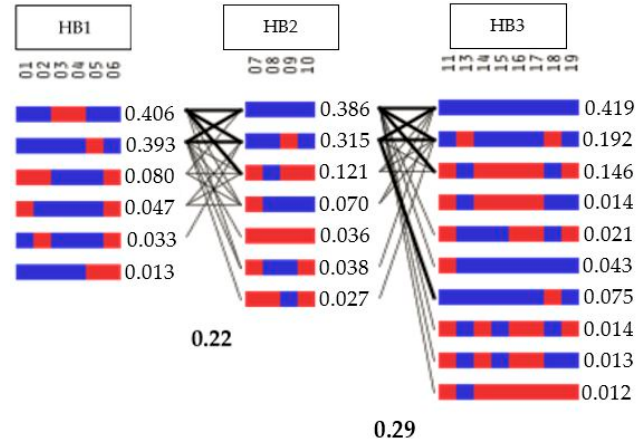
Figure 2. Estimation of the linkage disequilibrium between SNPs in the ACAC α gene. The blocks indicate haplotype blocks, and the text above the horizontal numbers indicates the SNP names. The values in the boxes are pairwise SNP correlations (r 2 ). The SNPs not in bold indicate that SNPs do not form a haplotype block with other SNPs.